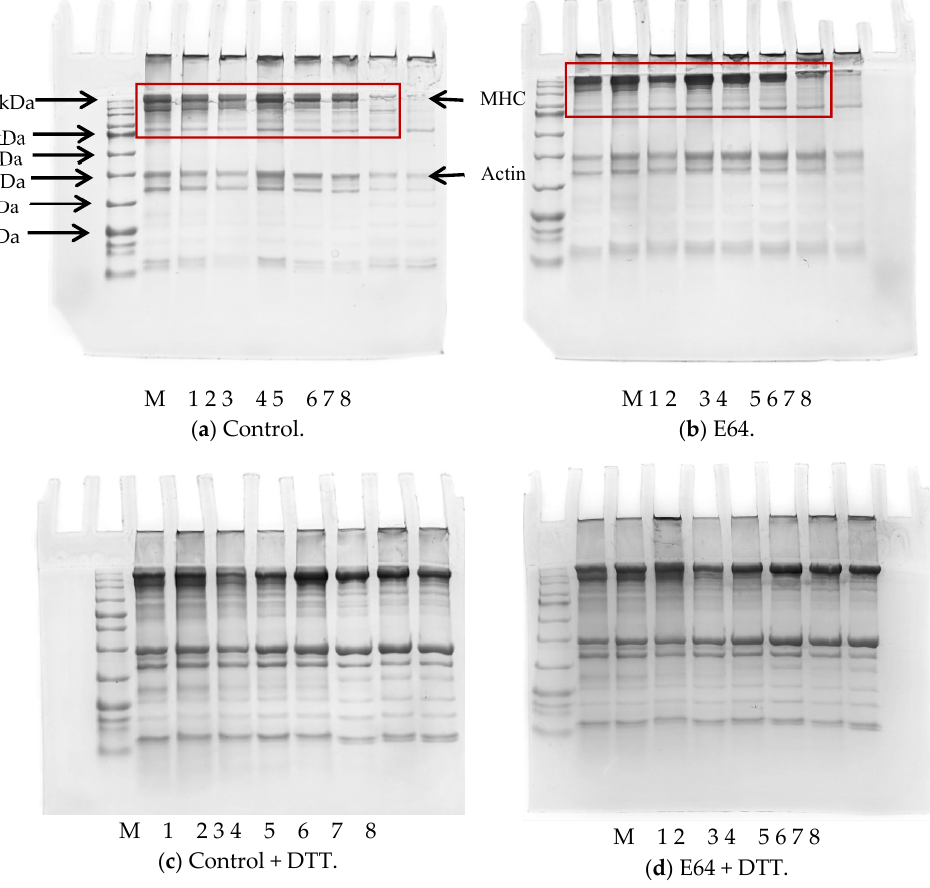
Figure 2. SDS-PAGE profile of myofibrillar protein from bighead carps under different H 2 O 2 concentrations: ( a ) control ( b ) E64; ( c ) control + DTT; ( d ) E64 + DTT. Lane M: marker; lanes 1–8: samples under 0, 0.1, 0.5, 1, 5, 10, 50, and 100 mM H 2 O 2 , respectively. MHC—myosin heavy chain.